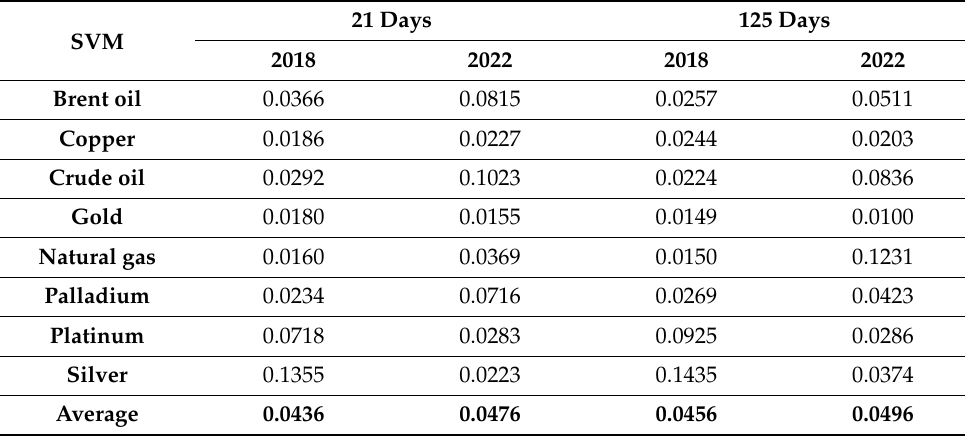
Table 10. Support Vector Machine (SVM) forecast